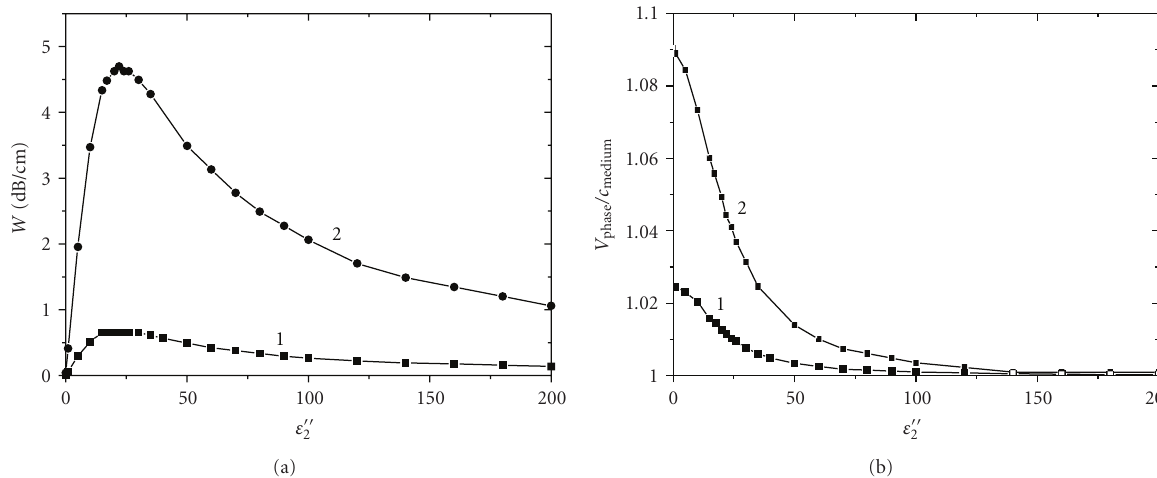
Figure 1: The wave attenuation W (a) and normalized phase velocity to the light velocity in medium 1, V phase /c mediun (b) on imaginary complex permittivity part ε (cid:2)(cid:2) 2 for the wave propagating along flat plane interface between low loss dielectrics and high loss media at frequency 31.82GHz, ε 2 = 20 + iε (cid:2)(cid:2) 2 Curves 1 are for ε (cid:2) 1 = 1 + i 0 (open air), curve 2 are ε (cid:2) 1 = 3 . 8 + i 0 . 0001 (quartz).